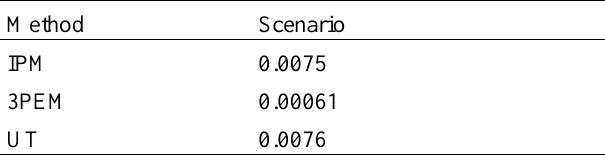
The comparison results for the three scenarios